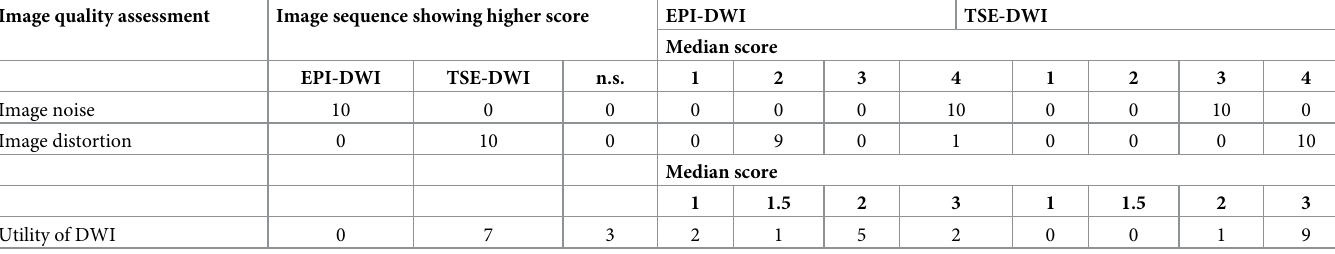
Table 6. Assessment of visual image quality of EPI-DWI and TSE-DWI by 10 readers and distribution of median scores. Image quality